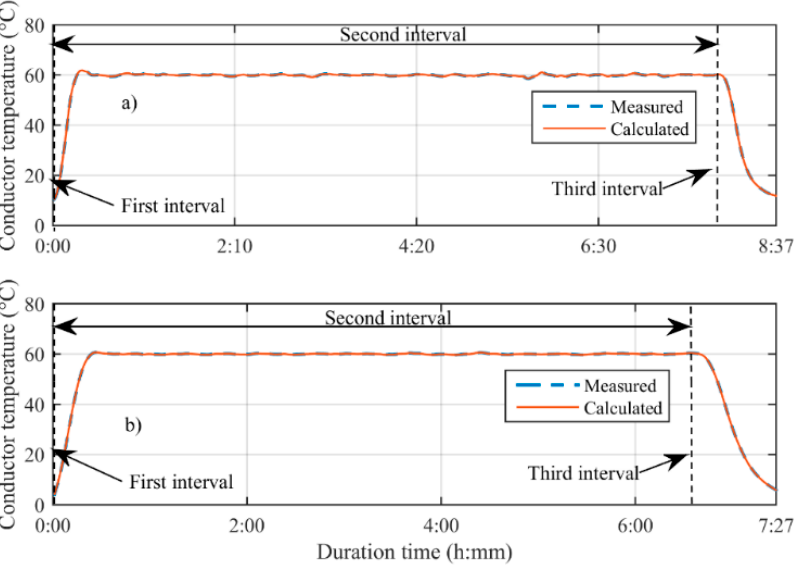
Figure 8. Measured and calculated conductor temperature at the conductor temperature 60 °C for the conductor: ( a ) AlFe 240/40 and ( b ) AlFe 490/65.